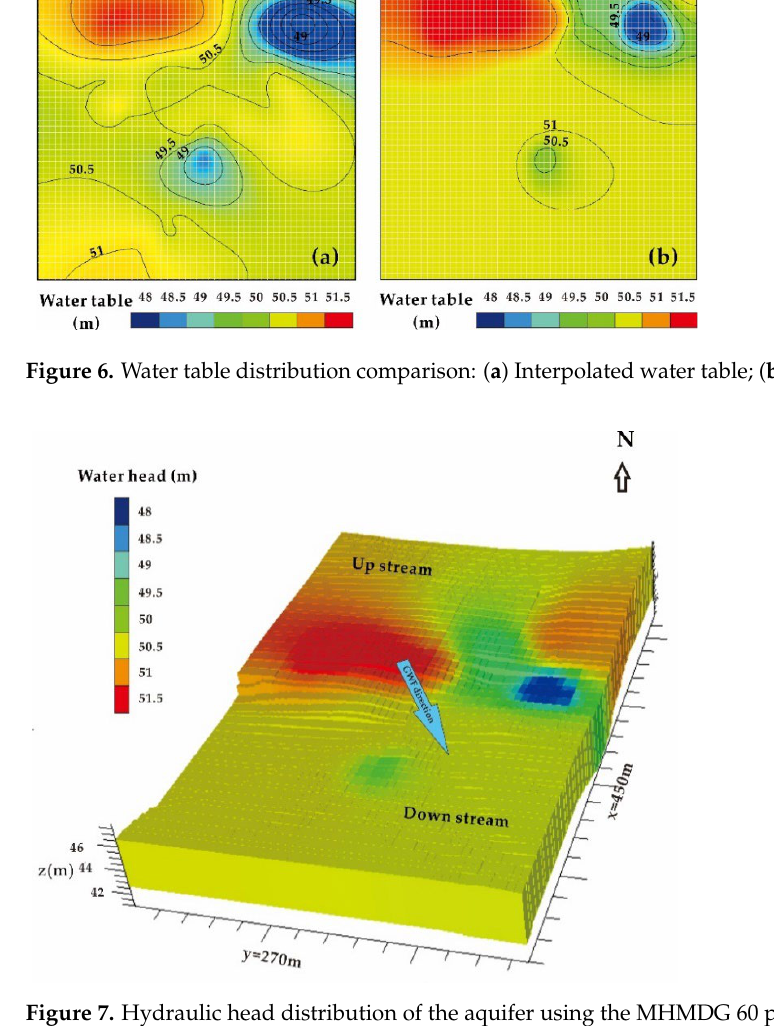
Figure 7. Hydraulic head distribution of the aquifer using the MHMDG 60 points placement calibration (Z exaggeration = 10 times).